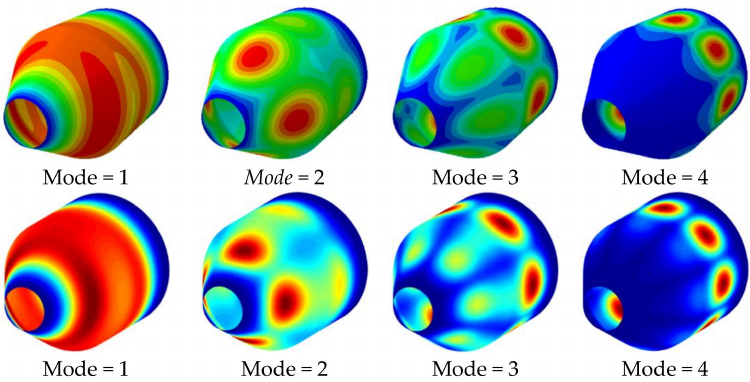
Figure 2. Mode shapes of laminated combined conical-cylindrical shell with CC boundary condition ( m = 1, ϕ = π /6) ( a ) ABAQUS ( b )